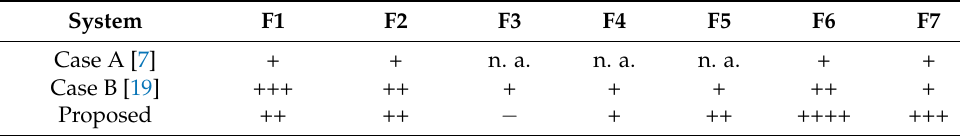
Table 1. Comparison